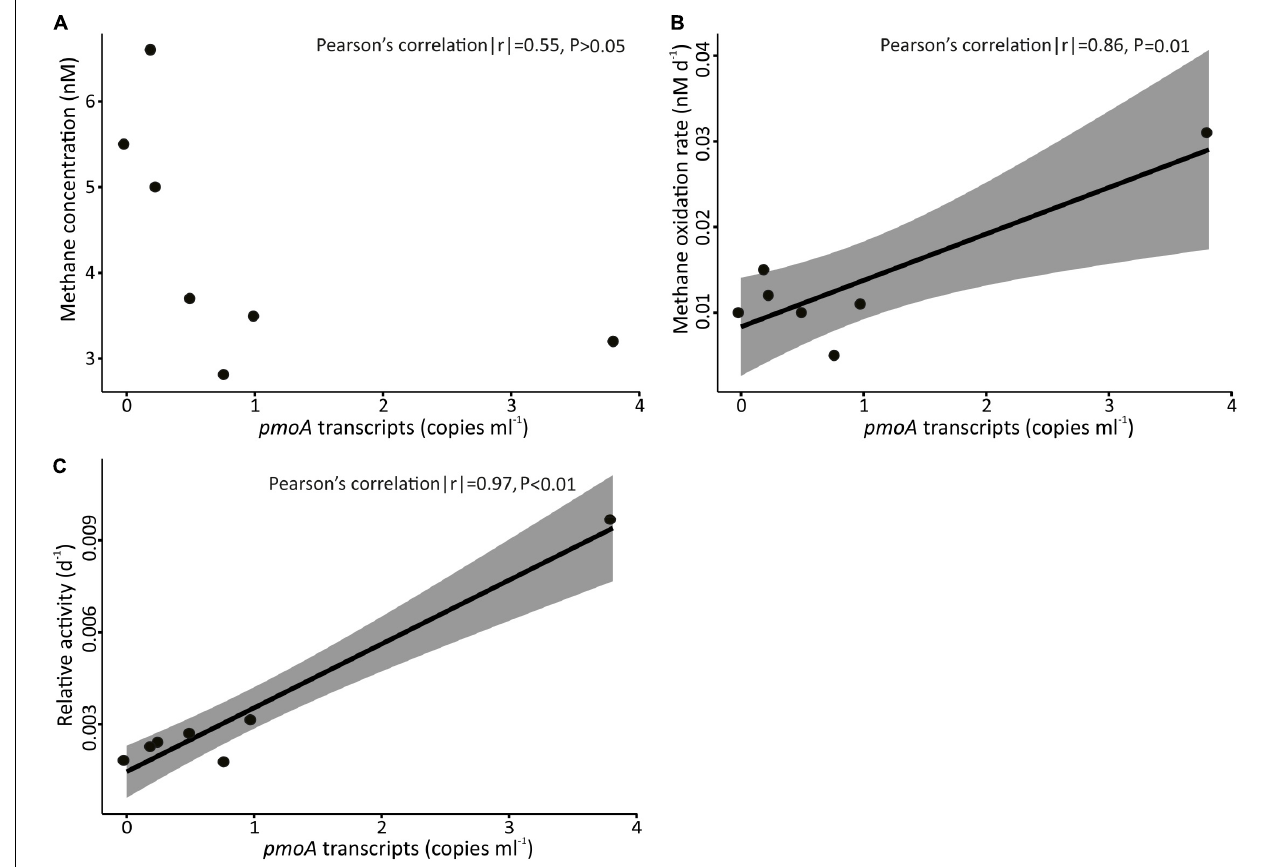
FIGURE 10 | Concentration of pmo A transcripts in samples collected above FWCR against (A) concentration of methane, (B) methane oxidation rate, and (C) relative activity. The shading represents ± 95% confidence intervals.